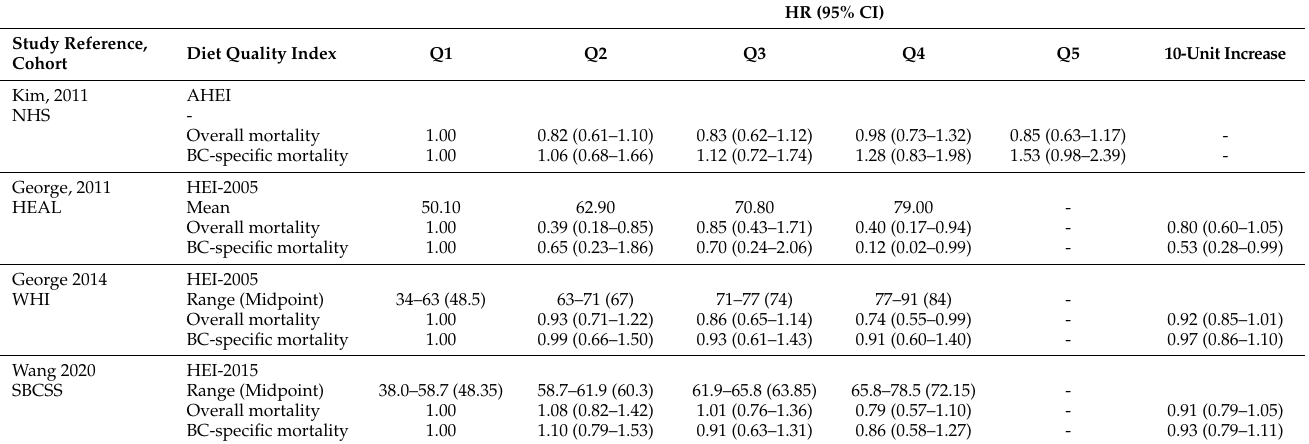
Table A2. Summary of cohort study data used for meta-analysis